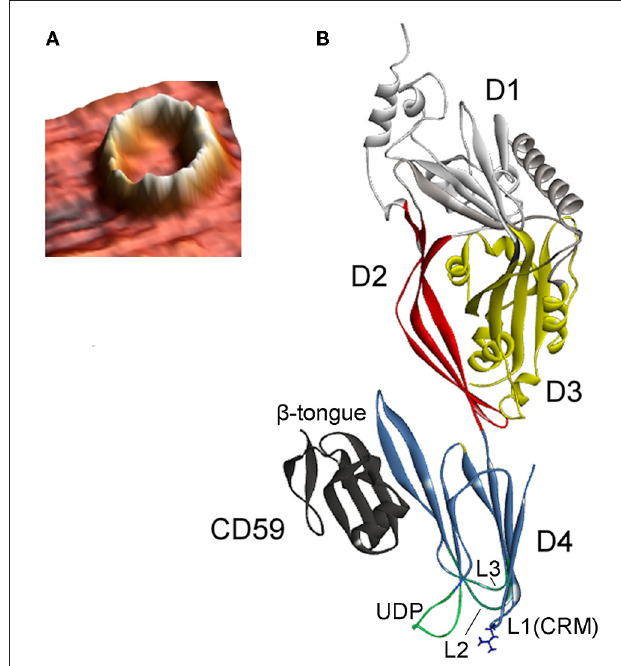
FIGURE 3 | (A) Atomic force microscopy three-dimensional topography image of the oligomeric structure obtained after reconstitution of VLY into a cholesterol-rich artificial bilayer. Calculated protrusion of the ring-shaped defect above the membrane is consistent with the height of inserted pore (reproduced with permission from Ragaliauskas et al., 2019). (B) Crystal structure of VLY in complex with hCD59 (PDB ID: 5IMY; Lawrence et al., 2016). VLY interacts with hCD59 via the β -tongue located in D4, similarly as ILY. Loop L1 contains the Thr-Leu (TL) pair of